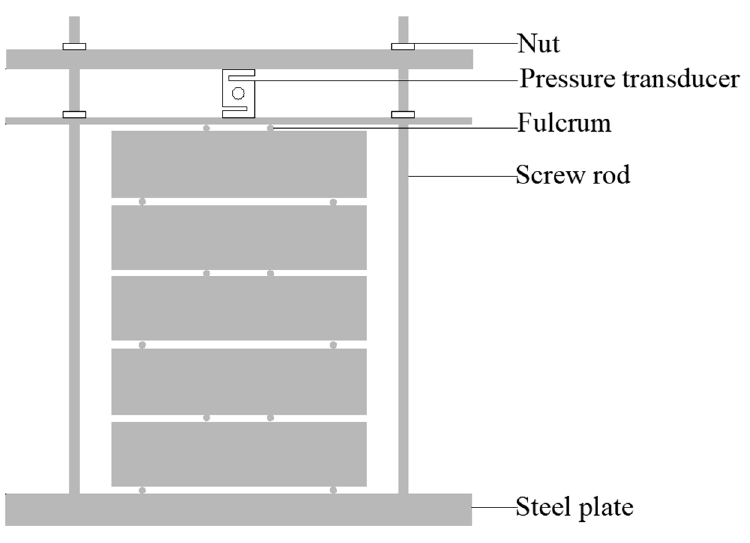
Figure 1. Diagram of bending loading device.